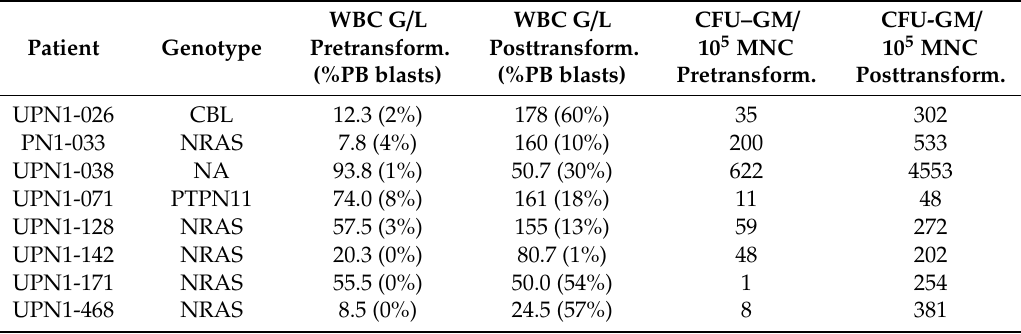
Figure 6. Time to AML transformation in CMML patients stratified by the presence or absence of spontaneous CFU-GM growth > 20 / 10 5 mononuclear cells. Table 1. White blood cell counts and numbers of spontaneously formed CFU-GM in 8 patients in whom in vitro cultures could be performed before and after transformation to secondary acute myeloid